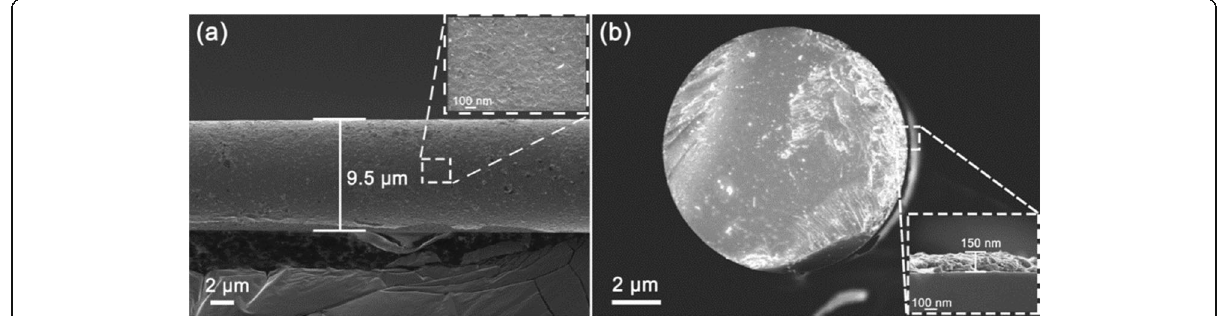
Fig. 4 a SEM image of the MF coated with WSe 2 . b Cross section view of the MF coated with WSe 2